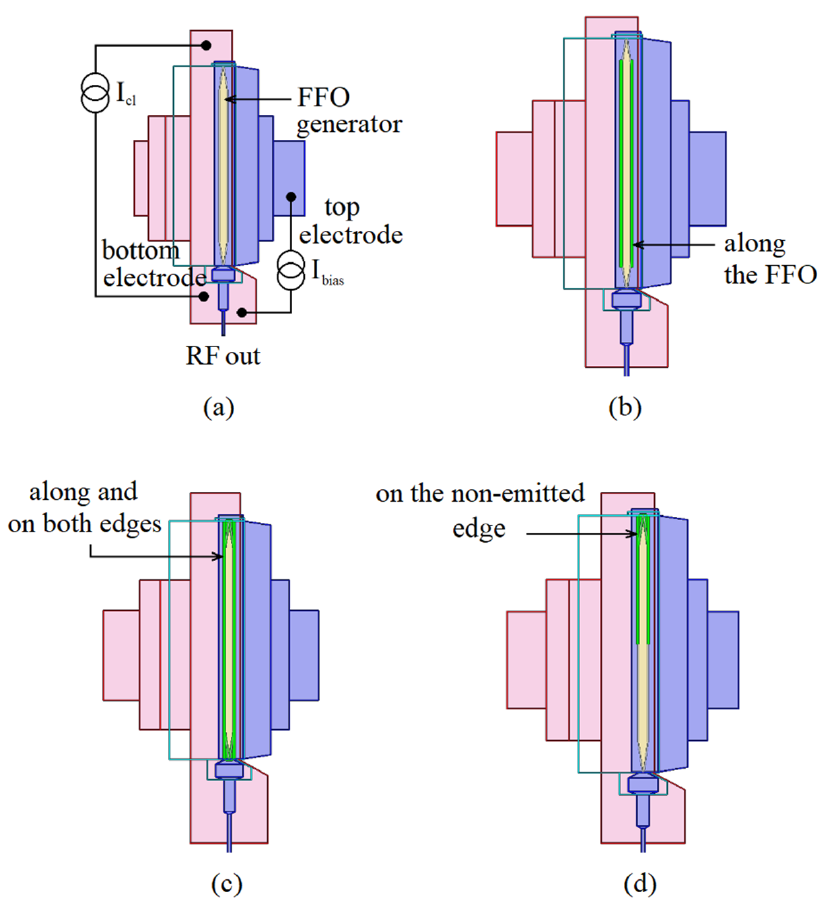
Figure 3. Layout of the FFO of different designs: ( a ) traditional FFO; ( b ) design with resistive layers along the FFO; ( c ) resistive layers along and on both ends of the FFO; ( d ) resistive layers on the non-emitting end of the FFO.